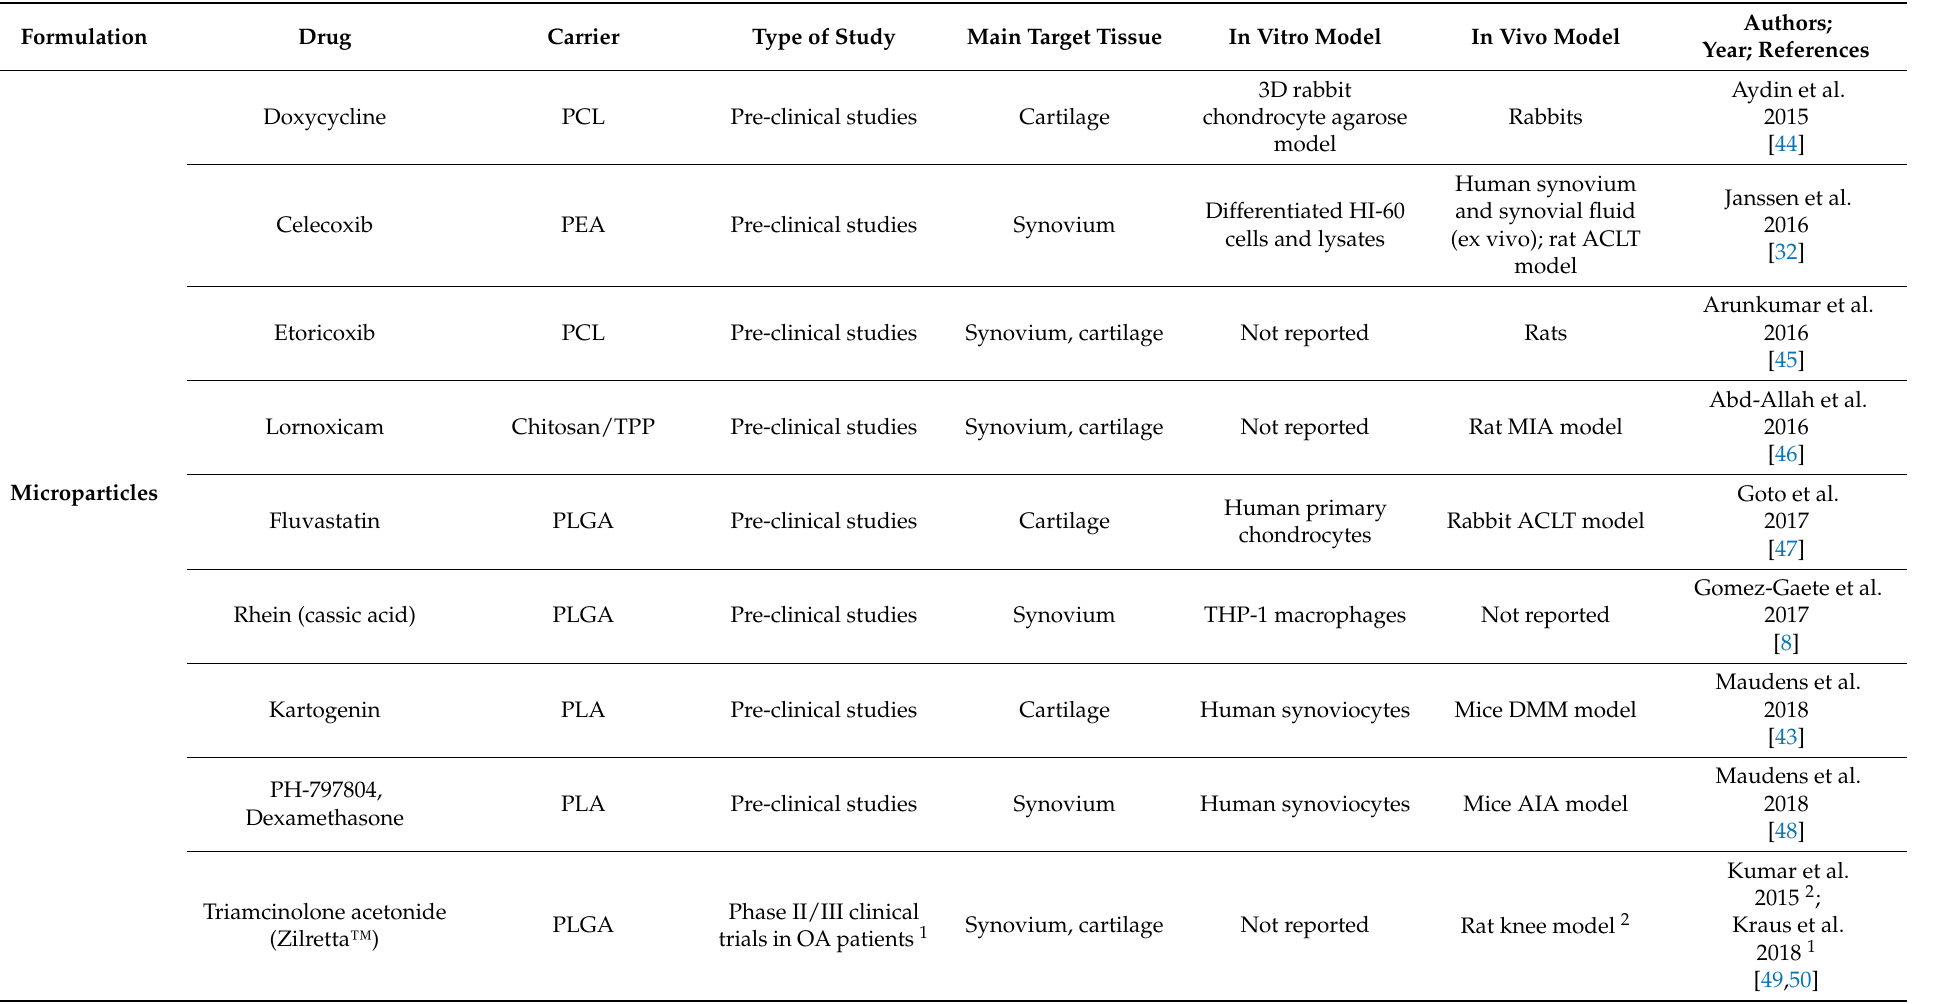
Table 1. Intra-articular small molecule drug delivery systems for OA treatment, developed in the past 5 years (Acronyms defined at the bottom of the